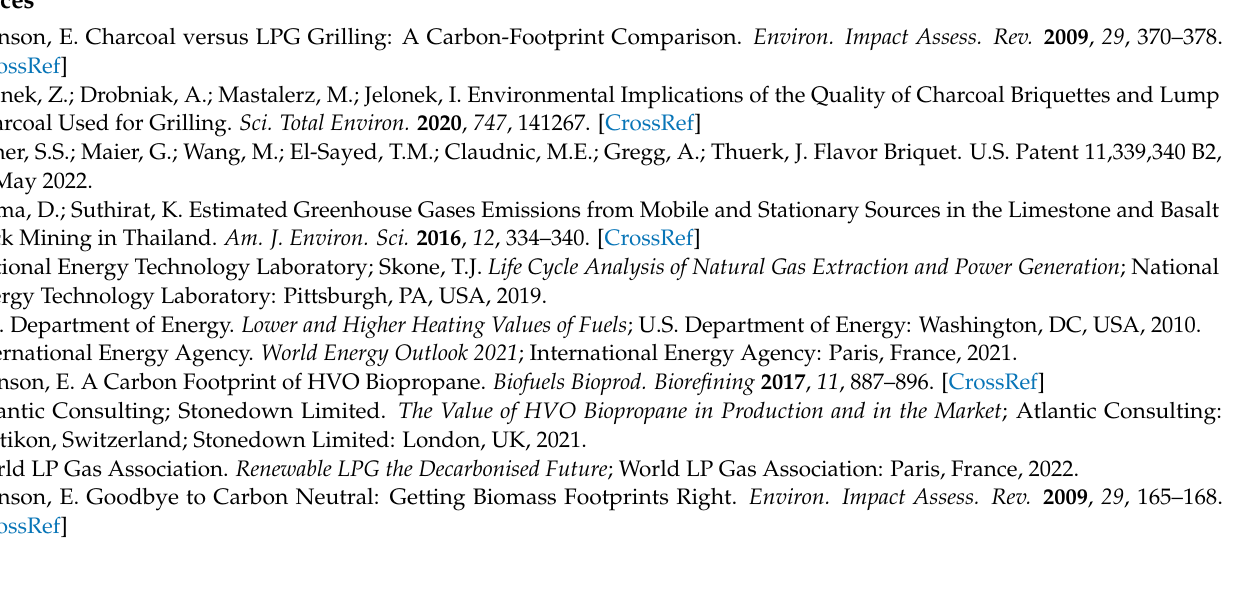
Figure 5. Grill-specific carbon footprints for grills, USA 2022 and alternate 2027. If biopropane were substituted for today’s fossil propane, the super-efficient gas grill would move slightly ahead of pellets, with its two less-efficient incarnations coming in third and fourth (similar results would come from substitution of natural gas with bio- methane, but this is less available to grills, so the biopropane case has been presented). Electricity lowers its footprint 20%, but still is relegated to fifth. Charcoal also makes a 20% improvement but comes in last. tainly destined to lower its footprint; for its competitors, improvement is a choice that